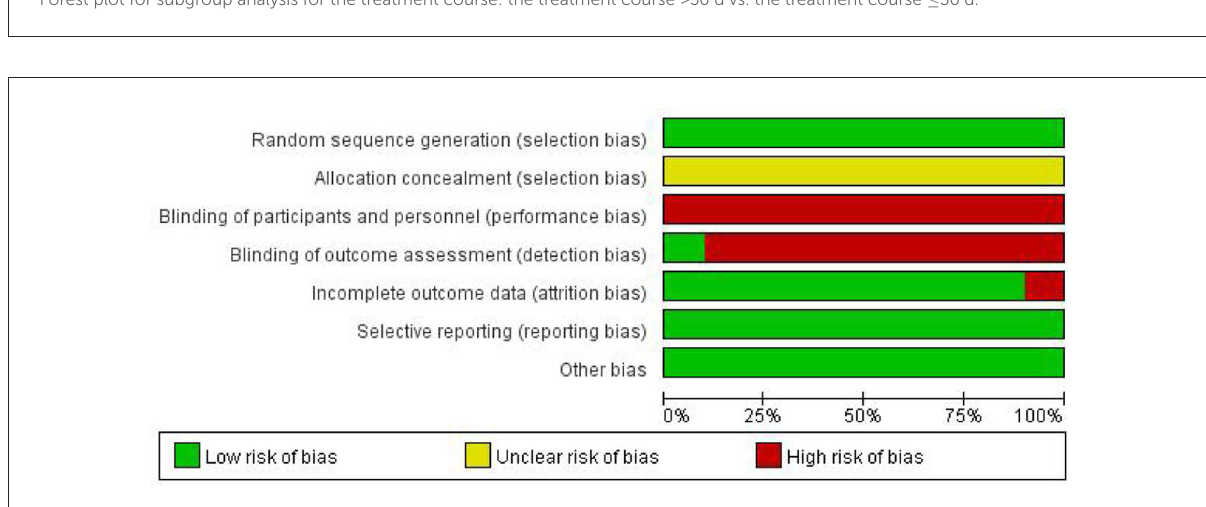
FIGURE9 Performance of each type of bias in all